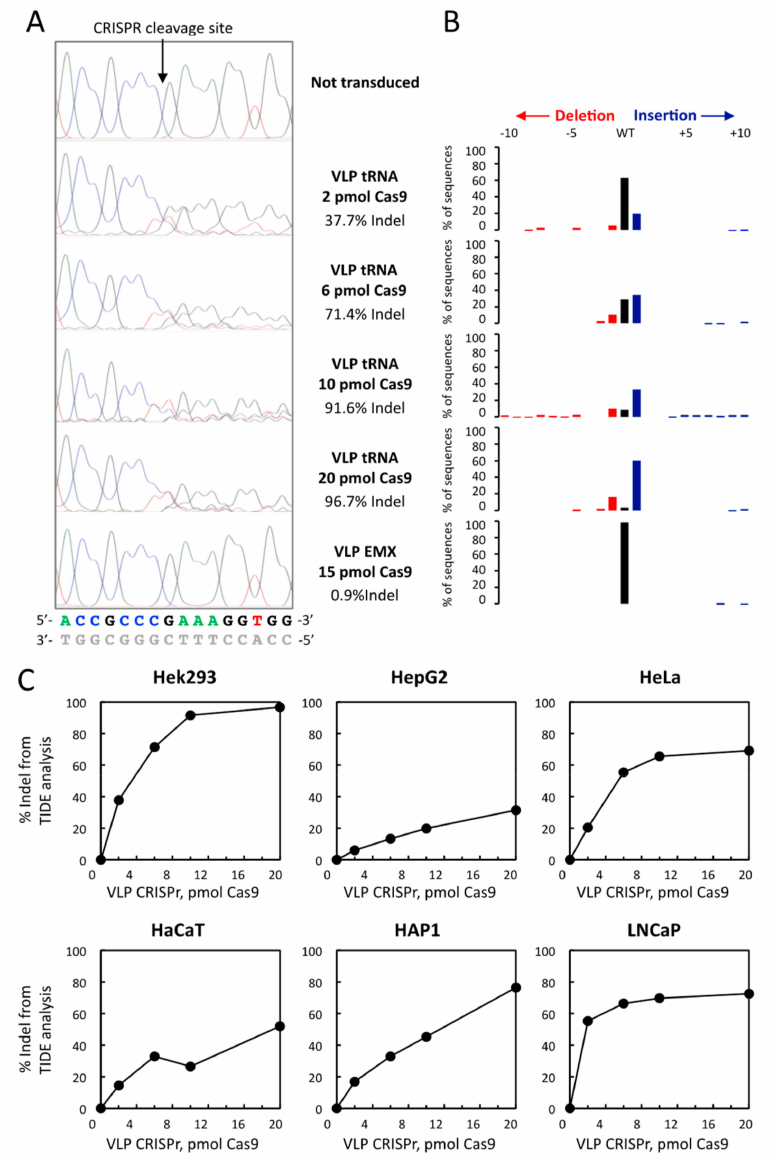
Figure 4. Evaluation of tRNA [Ser]Sec gene editing e ffi ciency by CRISPR-Cas9-VLPs with TIDE analysis. ( A ) Sanger sequencing of gDNA from Hek293 cells treated or not with tRNA or EMX VLPs. The PCR fragments encompassing the tRNA [Ser]Sec gene used in Figure 2 for T7 endonuclease 1 mismatch assay were sequenced. The traces (.ab1 files) and the associated WT sequence are shown with A (green), T (red), G (black), C (blue). The complementary sequence is shown in light grey. The Indel score (%) was calculated from the resulting percentage of WT sequence found with TIDE software analysis. ( B ) Histogram representation of the TIDE results. The profiles of all insertion and deletion (Indel) in the treated samples are shown with deletions in red, insertions in blue, and WT sequences in black. ( C ) The genome editing e ffi ciency was calculated with TIDE software for the six di ff erent cell lines treated with increasing amount